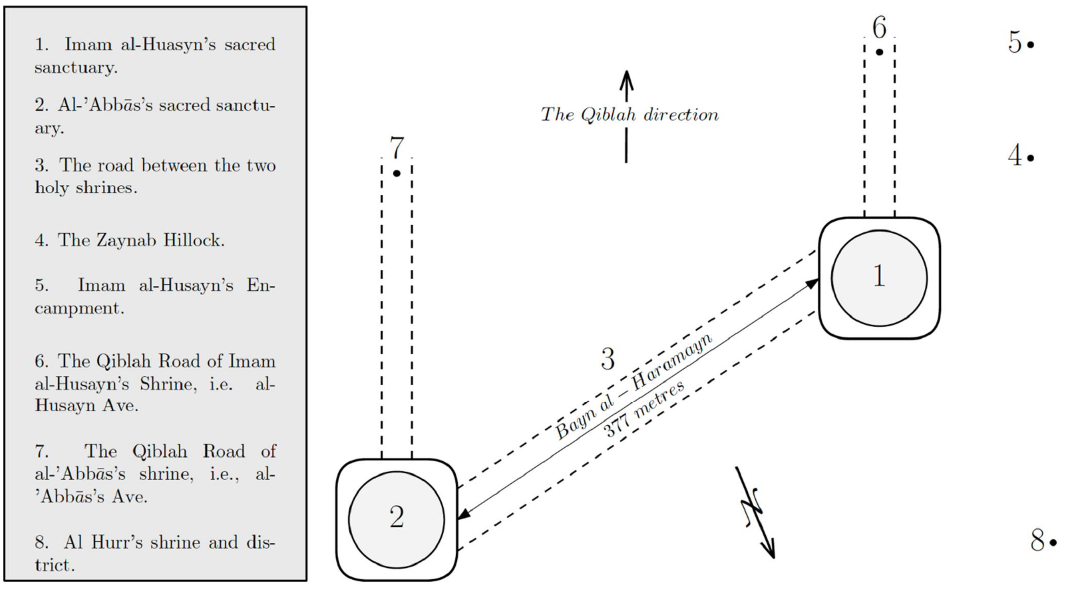
Figure 5. A Plan of the Main Pilgrimage Sites in Karbala. Source: Original graphic adapted from sketch provided by Muhammad-Reza Fakhr-Rohani, 2021. Dr Raouf Al-Ansari was a key architect of the redevelopment of Karbala as a holy city after the 2003 invasion. The Iraqi government initiated new programs to expand